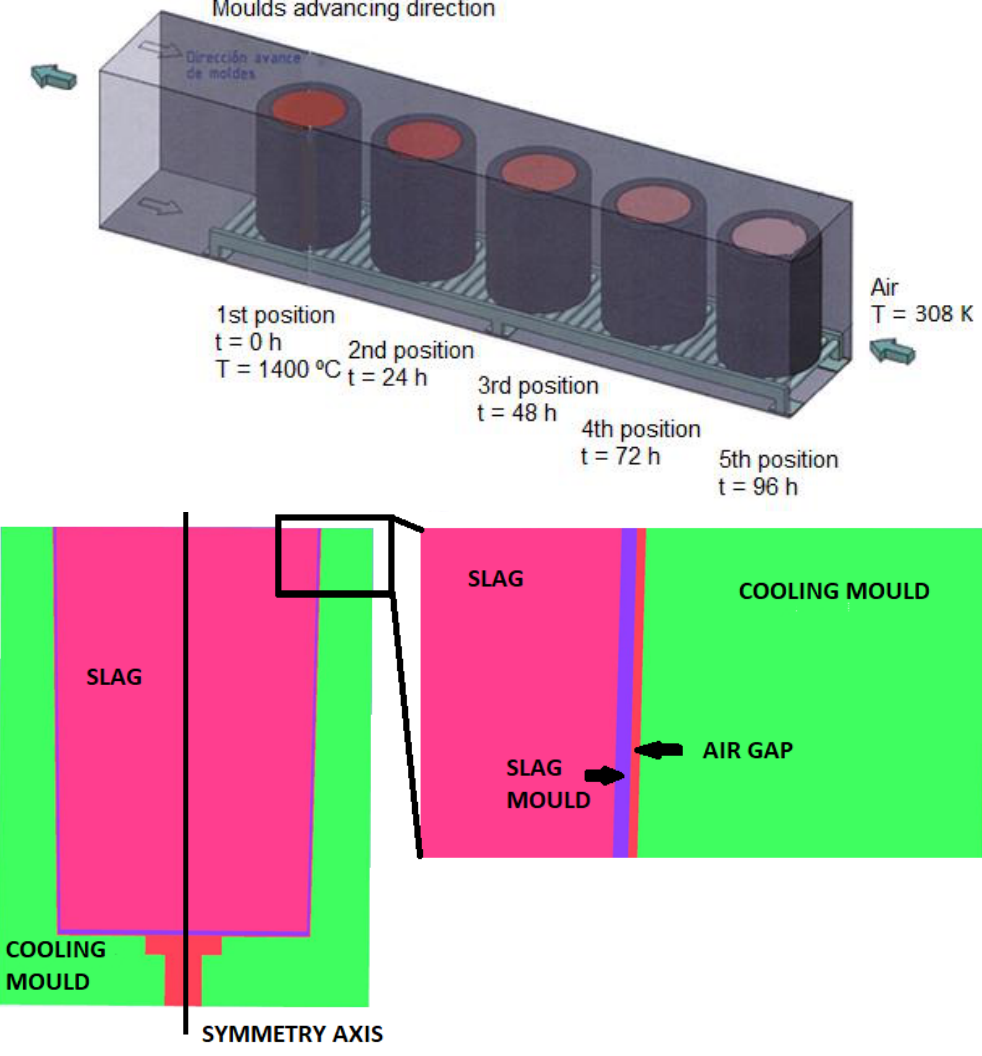
Figure 1. System sketch depicting the main operating procedure ( top ) and drum geometry ( bottom ).